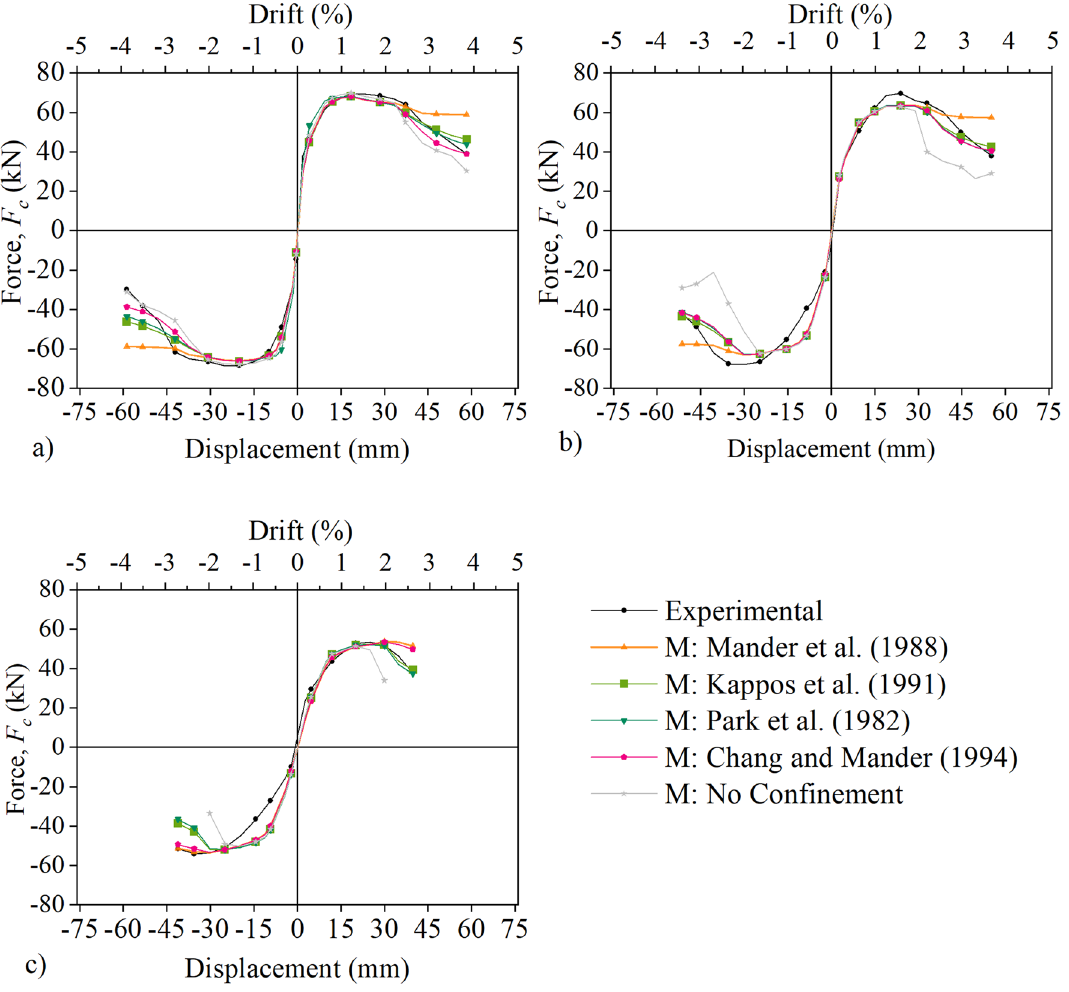
Figure 11. Lateral Force vs Displacement envelops: ( a ) column C, ( b ) column M, ( c ) column